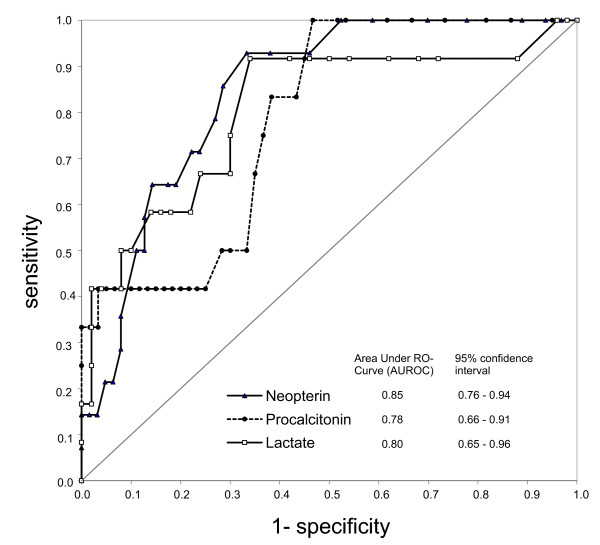
Receiver Operating Curves (ROC) characteristics of the diagnostic performance of neopterin, procalcitonin and lactate for severe P. falciparum malaria. The ROC curve is a graph of sensitivity (true positive fraction) plotted against 1-specificity (false positive fraction). The performance of a diagnostic variable can be quantified by calculating the area under the ROC curve (AUROC). The ideal test would have an AUROC of 1, whereas a random guess would have an AUROC of 0.5.